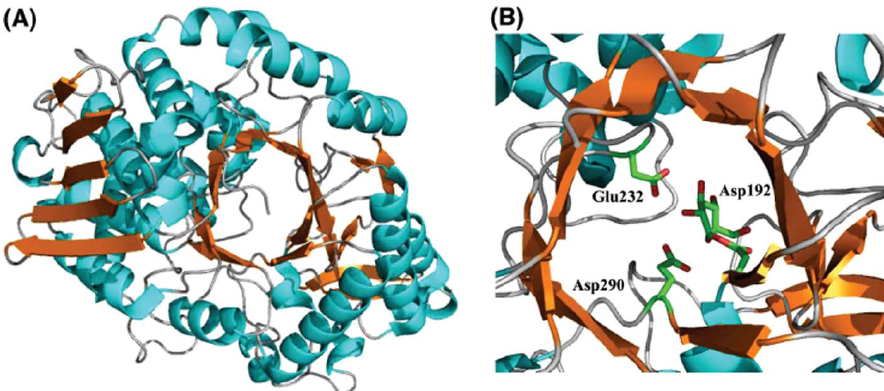
Figure 6. ( A ) Helix and sheet representation for a monomer unit of SP from B. adolescentis . Crystal structure reported in PDB entry 1r7a. ( B ) Close-up view of the active site of SP from B. adolescentis (PDB entry 2gdv, chain a). The residues highlighted belong to the catalytic triad Asp192 (glucosylated in the structure), Glu232 and Asp290. Figure from reference [102]. Reprinted by permission from the publisher Taylor & Francis Ltd., London, England. http://www.tandfonline.com (accessed on 1 October 2022).